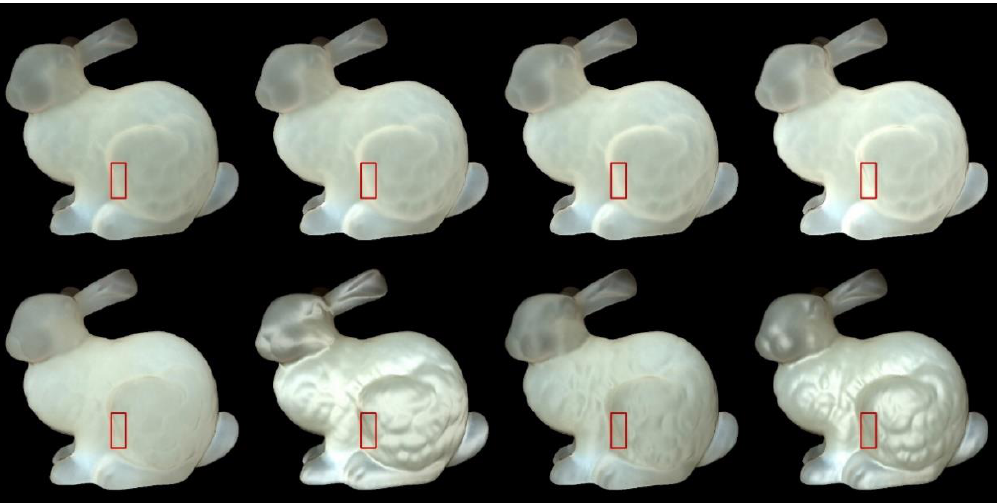
Figure 6. Comparison of highlight effects generated by our Ward-based method (first row) and the method based on the traditional Ward model (second row) for chocolate milk (regular) material. From left to right, the n t , n b parameters are n t is 2, n b is 2; n t is 2, n b is 10; n t is 10, n b is 2; n t is 10, n b is 10.